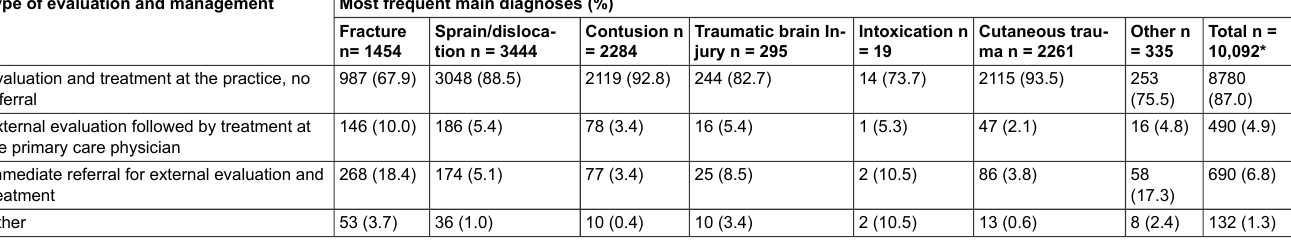
Table 4: Evaluation and management characteristics by type of injury following a first consultation for injury in primary